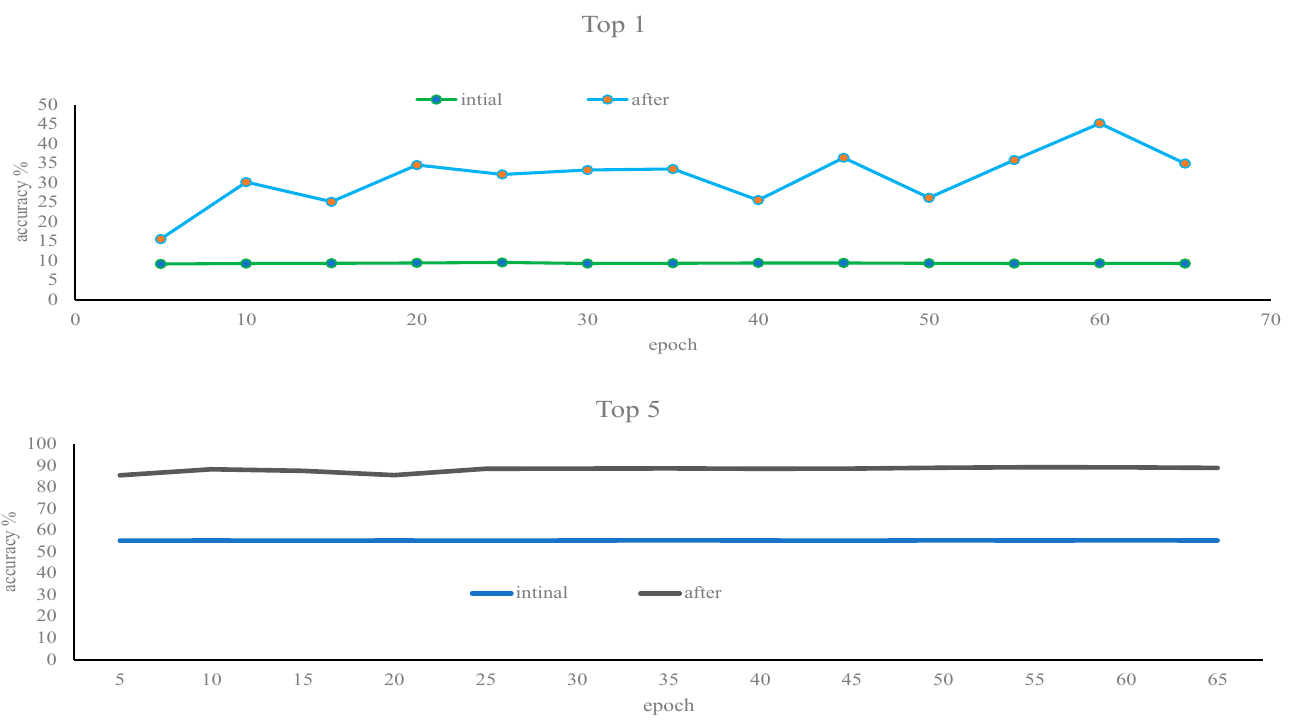
Figure 8. The comparison chart of the initial and modified recognition rates of Top1 and Top5.